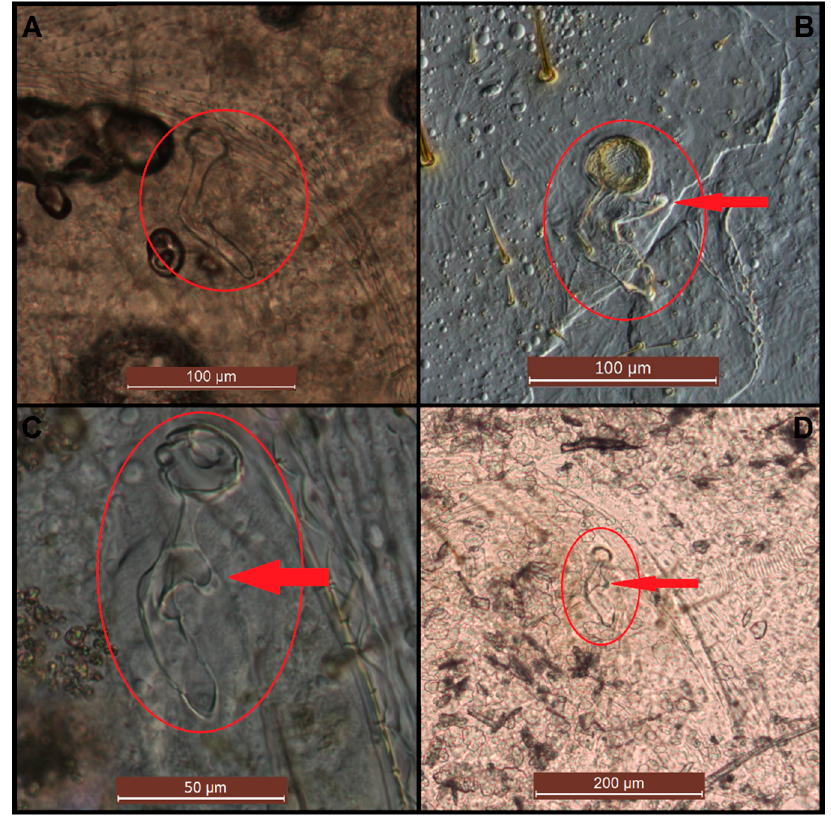
Figure 4. Dissected spiracles (red circles) at various magnifications. ( A ) Co. formosanus ; ( B ) N. jouteli ; ( C ) C. cavifrons ; ( D ) C. brevis . The red arrows indicate spiracular protuberances (secondary atrial arms).